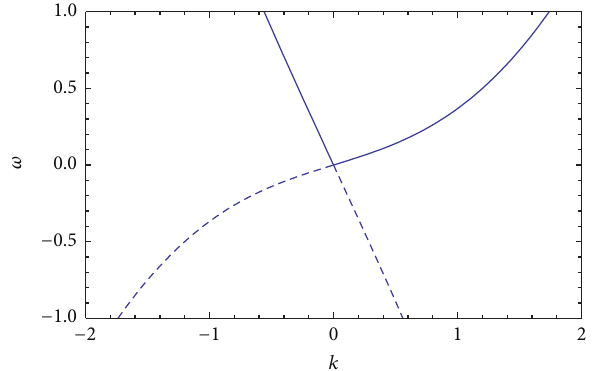
Figure 1: Dispersion relation in the subsonic region ( 𝜔 is given in units of the chemical potential and 𝑘 in units of the healing length).